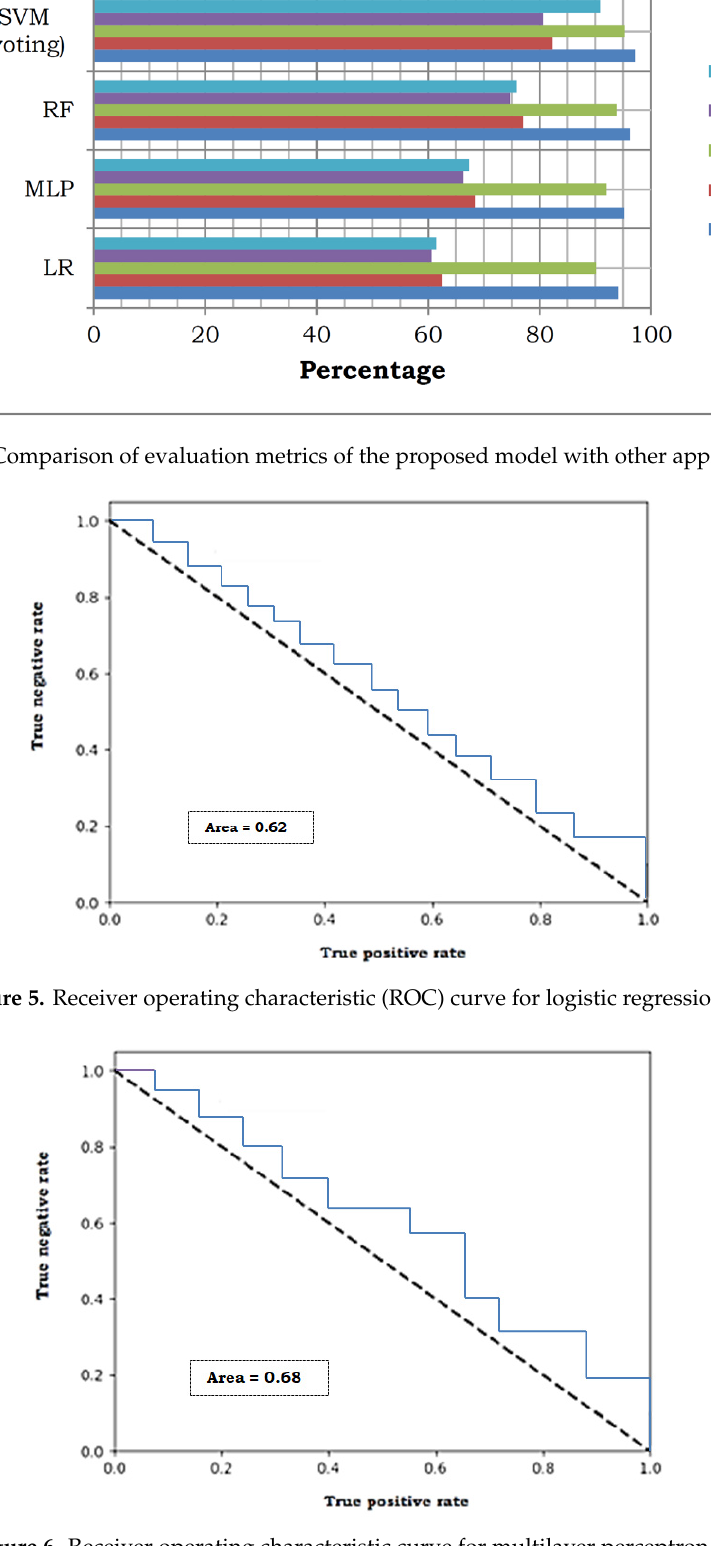
Figure 7. Receiver operating characteristic curve for random forest. Figure 8. Receiver operating characteristic curve for bagging SVM (majority voting).